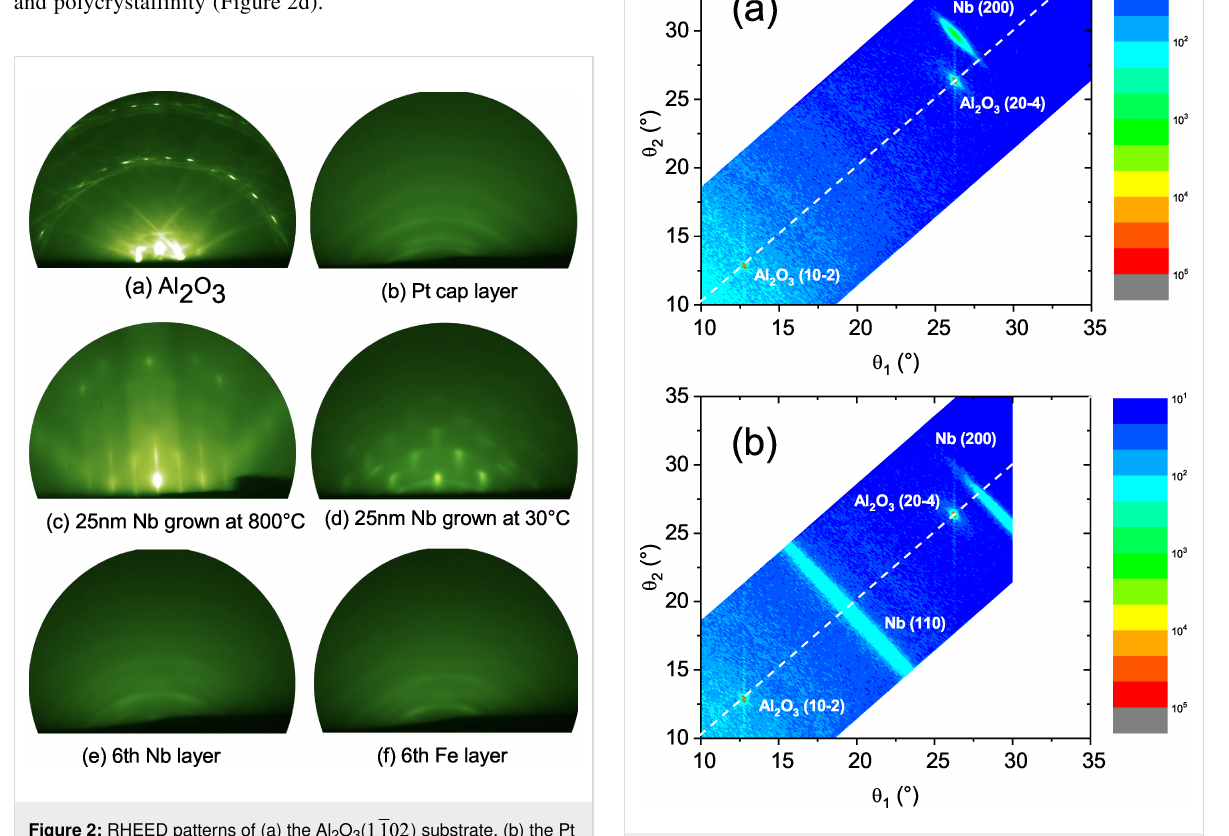
Figure 3: X-ray diffraction patterns of (a) sample s3 and (b) sample s6. Dashed tilted lines show the direction of specular reflection. The color bars show the logarithmic intensity